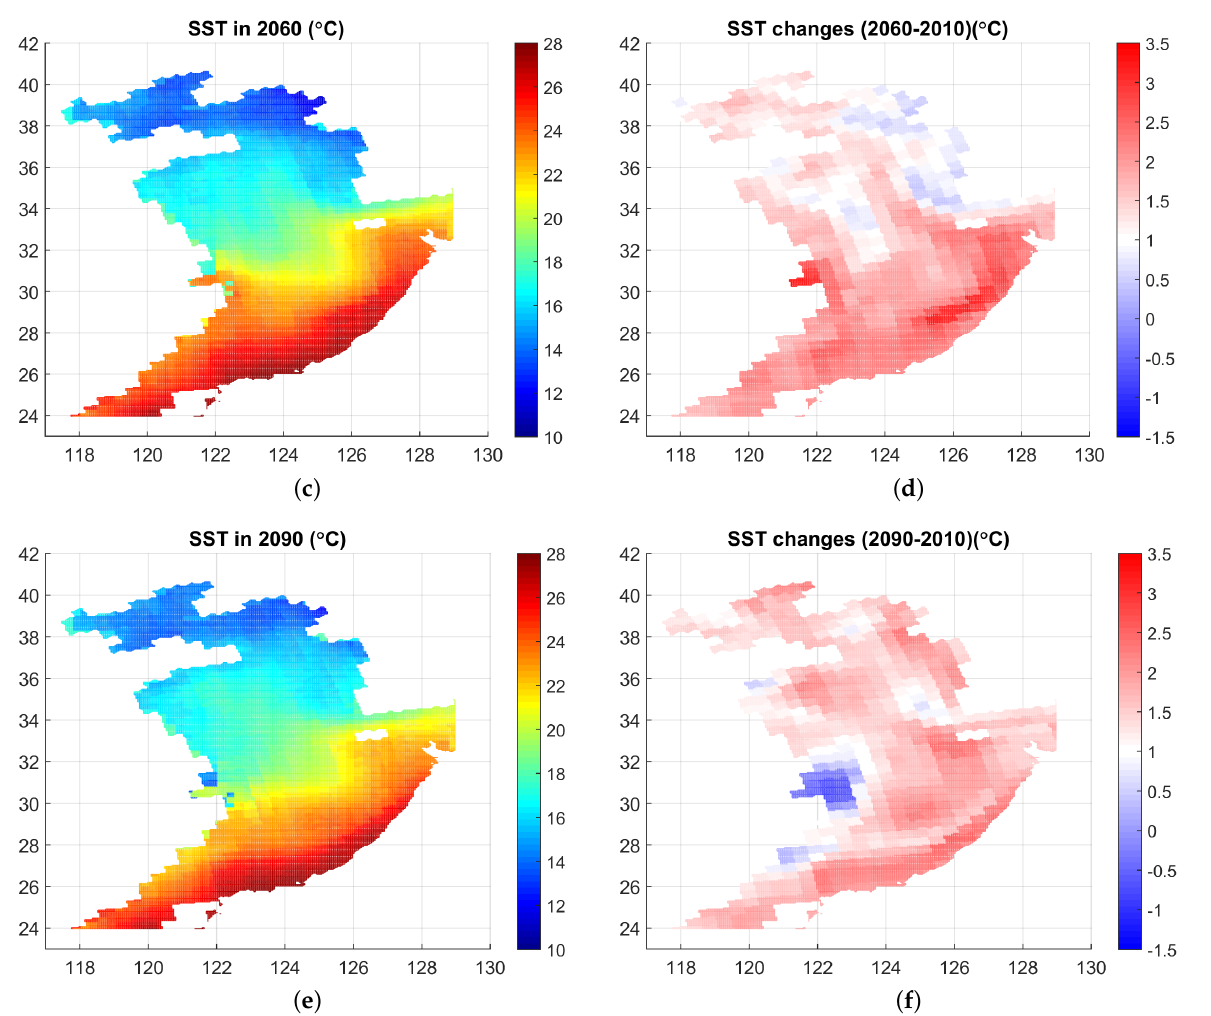
Figure 5. The projection results of decadal SST changes by MPI-ESM-MR in ( a ) 2030, ( c ) 2060, and ( e ) 2090 and their changes compared to that in 2010 in ( b ) 2030–2010, ( d ) 2060–2010, and ( f )